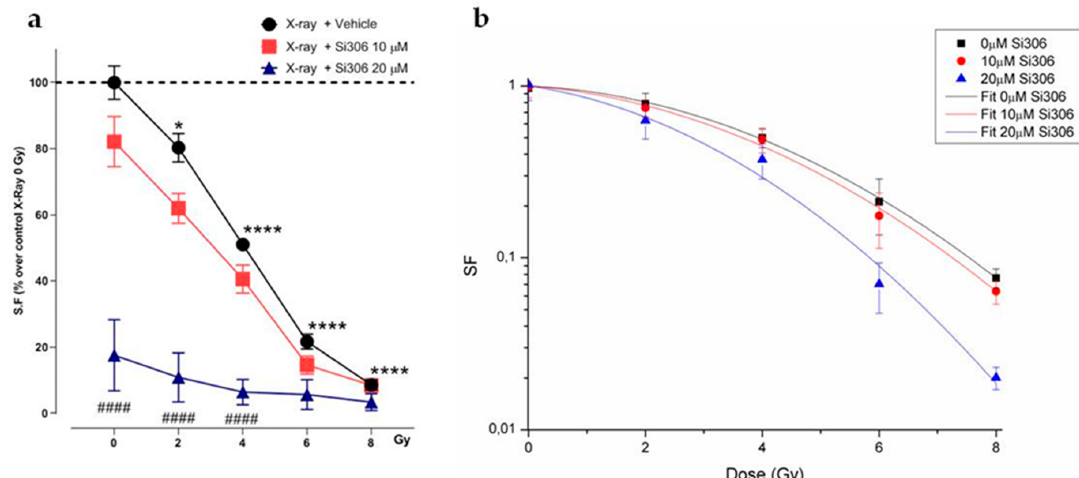
Figure 3. Cell survival of irradiated cells in normoxia with Si306 exposure. (a) SF plot of normoxic U251-MG cells exposed to 0, 2, 4, 6 and 8 Gy and treated with vehicle, 10 or 20 µM Si306. Data are mean ± SEM of n = 3 independent experiments. * p -value < 0.05 and **** p -value < 0.0001 versus 0 Gy in normoxia; #### p -value < 0.0001 versus only irradiated cells with 0, 2 and 4 Gy in normoxia (F Si306conc . = 89.17, p -value < 0.0001; F Gy = 124.5, p -value < 0.0001; F Si306conc. x Gy = 14.64, p -value < 0.0001. Two-way ANOVA with Holm–Šídák post-hoc test Two-way ANOVA with Holm–Šídák post-hoc test). (b) Linear-quadratic adjustment of the data of U251 cell survival curves treated with X-rays only and combined with Si306 in normoxia.